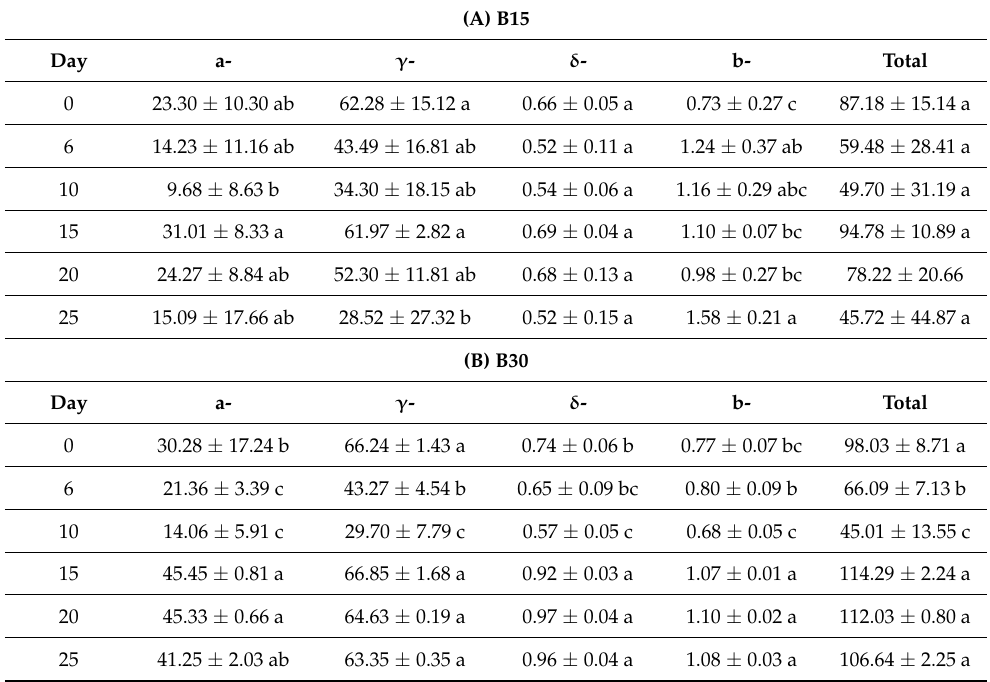
Table 2. Changes in individual and total tocopherol content (mg kg − 1 of butter sample) of cottonseed butters over the accelerated oxidation storage at 60 ◦ C. B15 and B30 are butter products made from the cottonseed roasted at 150 ◦ C for 15 and 30 min, respectively. Data are presented as average ± SD (n = 3). Same letters in the same column indicate that these values are not statistically significantly different ( p >